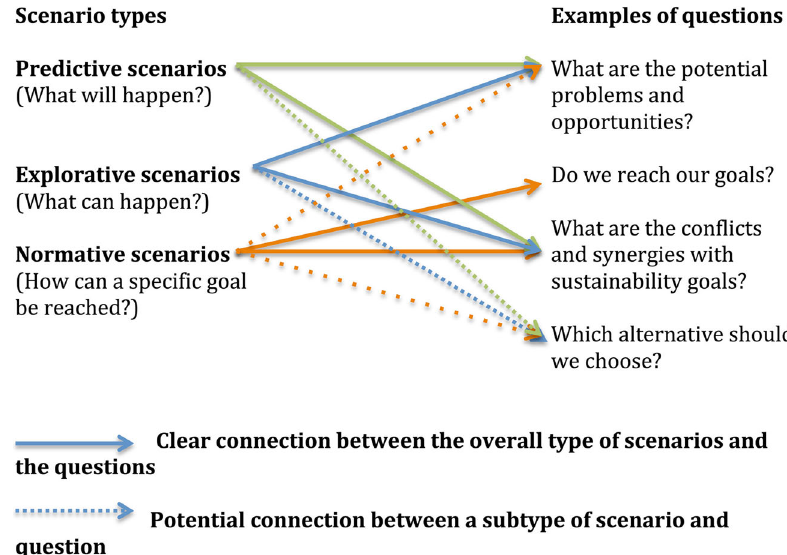
Fig. 1 Examples of